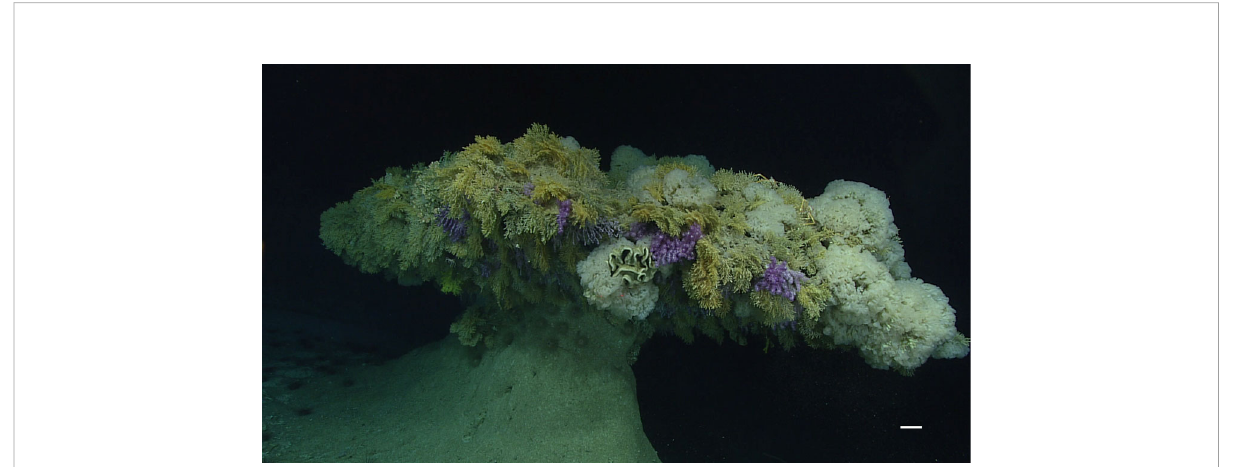
FIGURE 1 Deep-sea rock with a variety of sponges, corals, and other organisms. Red lasers on the center of the rock are 10 cm apart, and the white scale bar is 10 cm long (EX1705 Dive 5 Jarvis Island, 375 m). Morphotypes found on this feature include glass sponges, crabs, octocorals, scorpion fi sh, thin eels, sea urchins, snails, squat lobsters, and zoanthids. Photo credit: NOAA Ocean